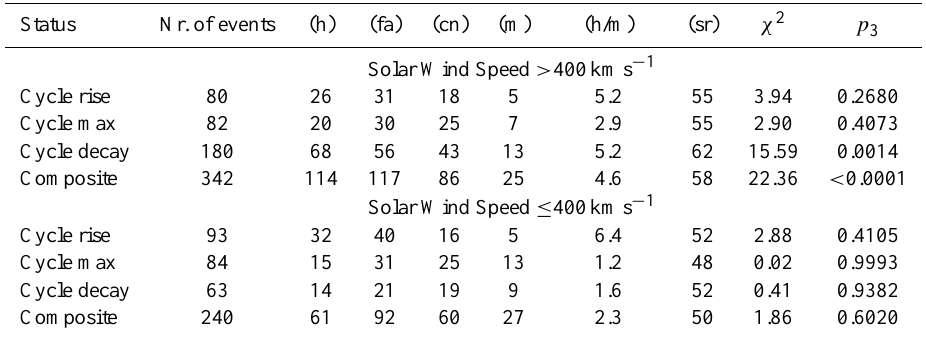
Table 6. Performance of the HAFv.2 model with respect to the speed of the background solar wind during the key phases of solar cycle 23 and during the total cycle. The top four panels show the statistics when the speed was > 400kms − 1 and the bottom four panels when it was ≤ 400kms − 1 at the times of shock initiation.